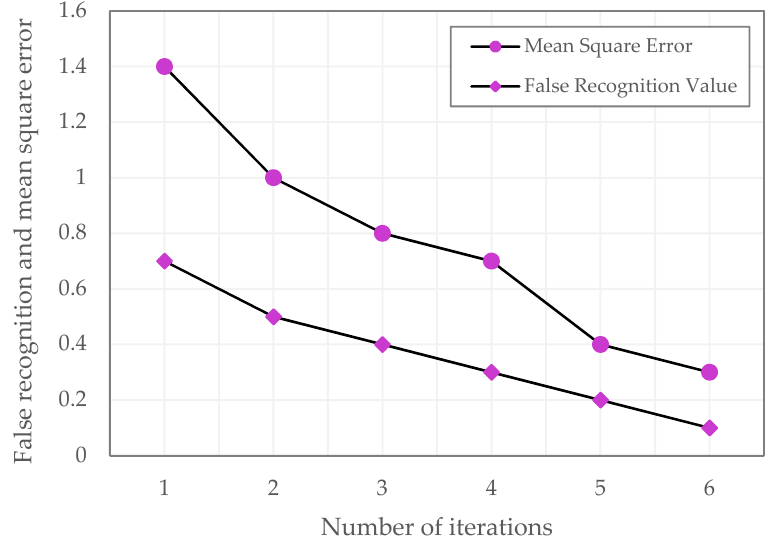
Figure 5. LPRNN training outcome. Table 2. Image noise removal state-of-art method.